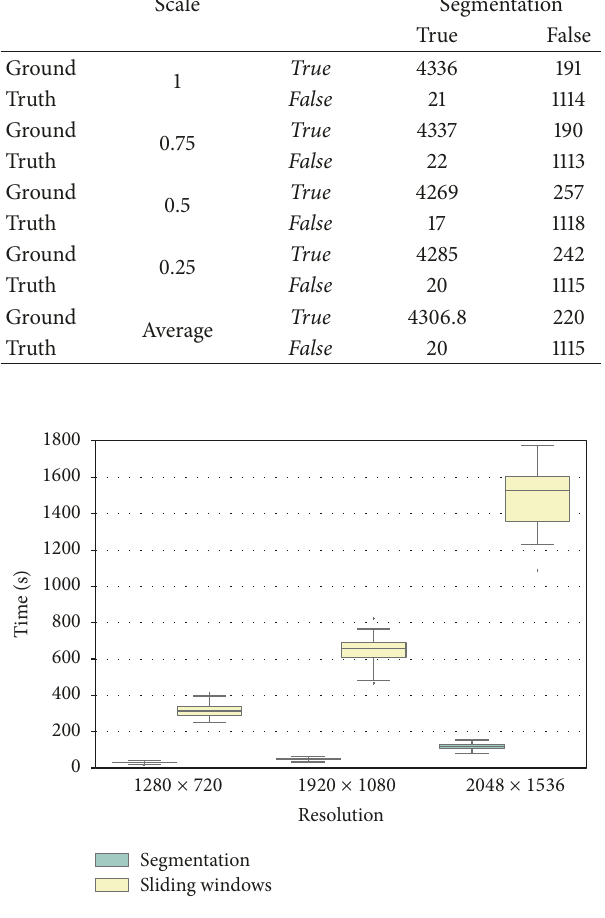
Figure 14: Time comparison using segmentation and sliding win- dow techniques. Interquartile ranges: 25%, the median and 75% of the